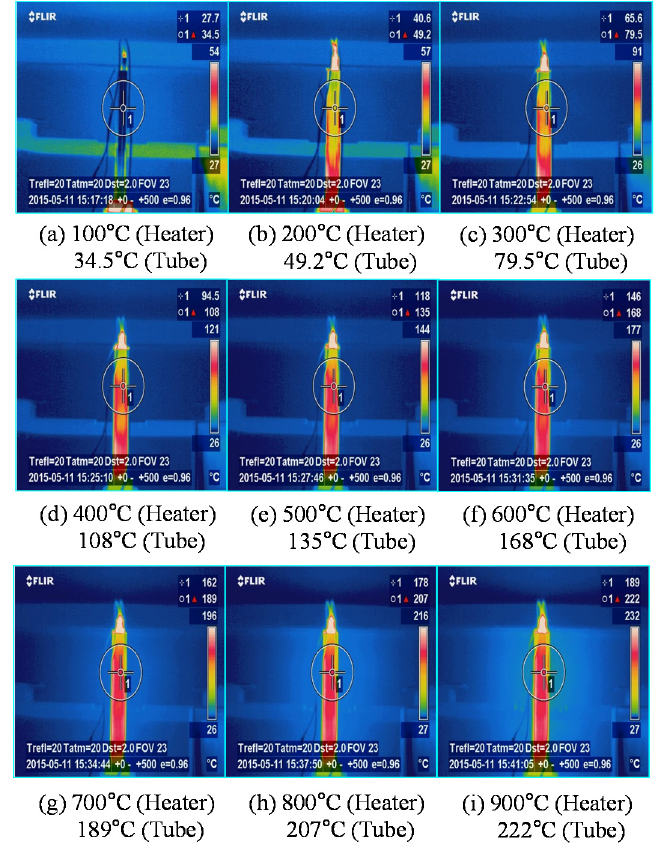
Figure 7. Thermal imaging contours captured by the thermo-graphic camera (T3-2 Model). ( a ) 100 ˝ C heater ( b ) 200 ˝ C heater ( c ) 300 ˝ C heater ( d ) 400 ˝ C heater ( e ) 500 ˝ C heater ( f ) 600 ˝ C heater ( g ) 700 ˝ C heater ( h ) 800 ˝ C heater ( i ) 900 ˝ C